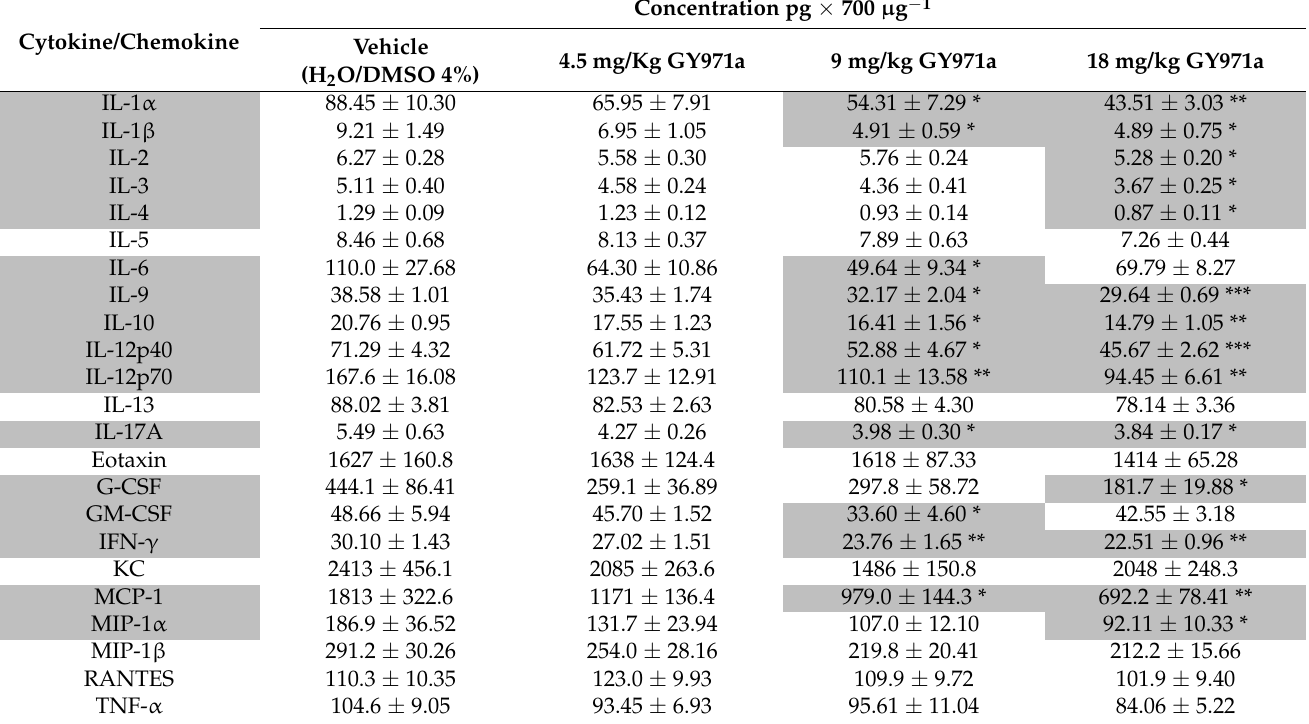
Table 4. Cytokine and chemokine concentrations in supernatant of lung homogenates following acute P. aeruginosa airway infection and GY971a (pANDMA) treatments. Data are expressed as mean values ± standard errors of the means (SEM) pooled from two independent experiments (N = 8–10). Statistical significance is determined by one-way ANOVA with Dunnett’s multiple comparisons test and significant differences between treatments and the vehicle are highlighted in gray, using